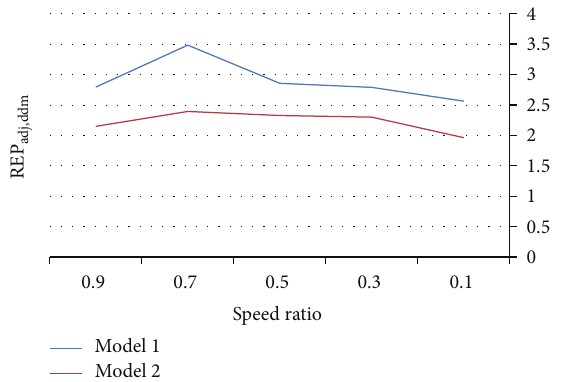
changes with respect to speed adj , fd & ddmfd